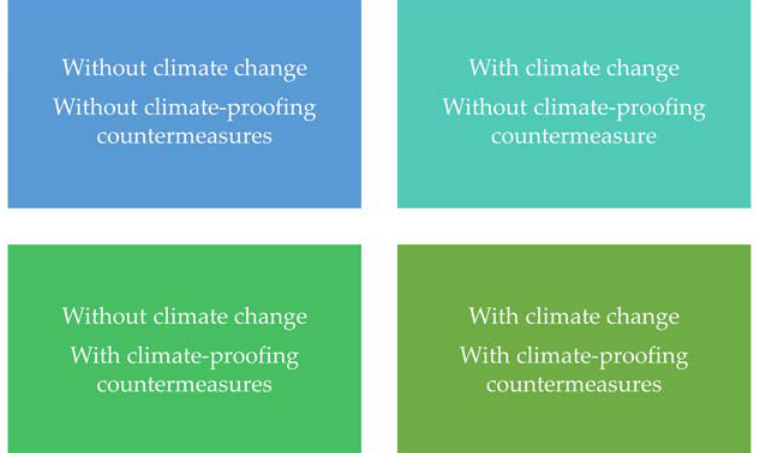
Figure 4. General scenarios for discussion on climate adaptation.